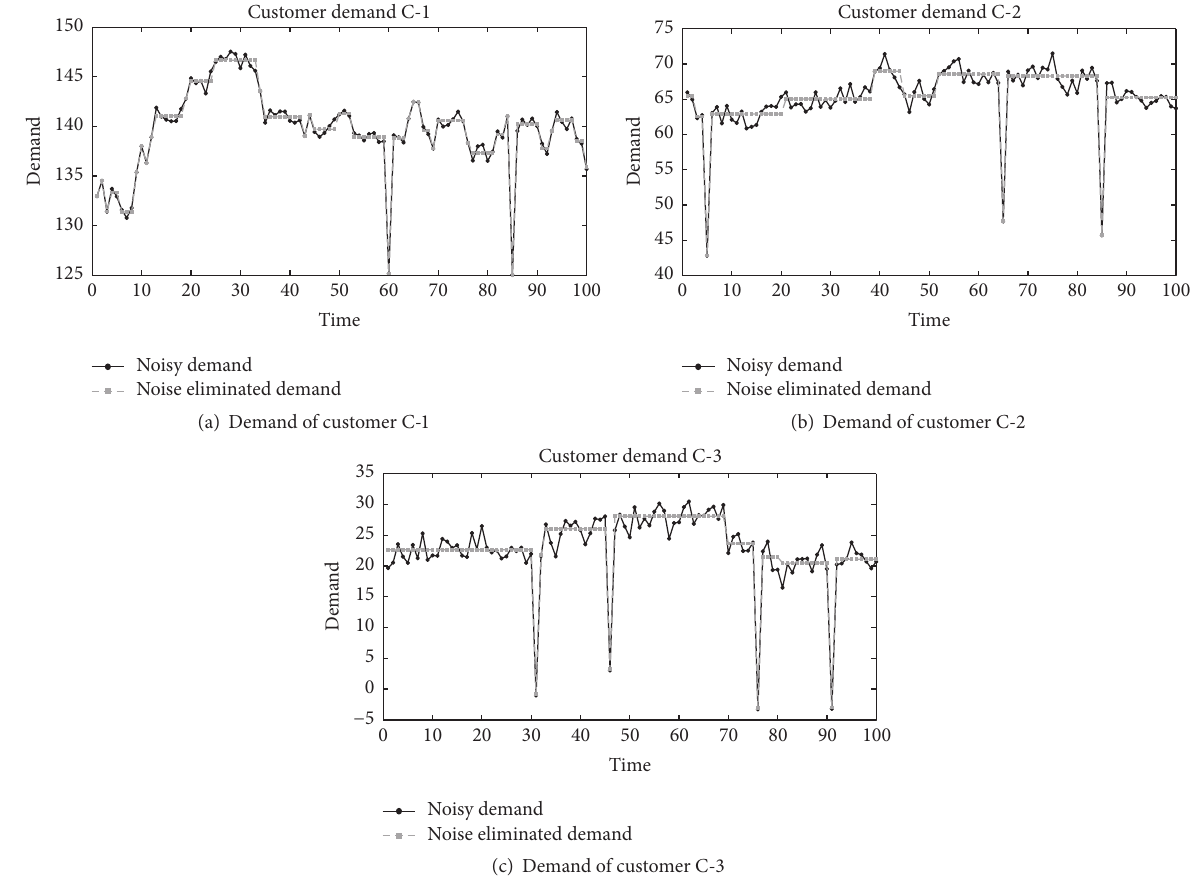
Figure 9: Noisy data and filtered data for customer